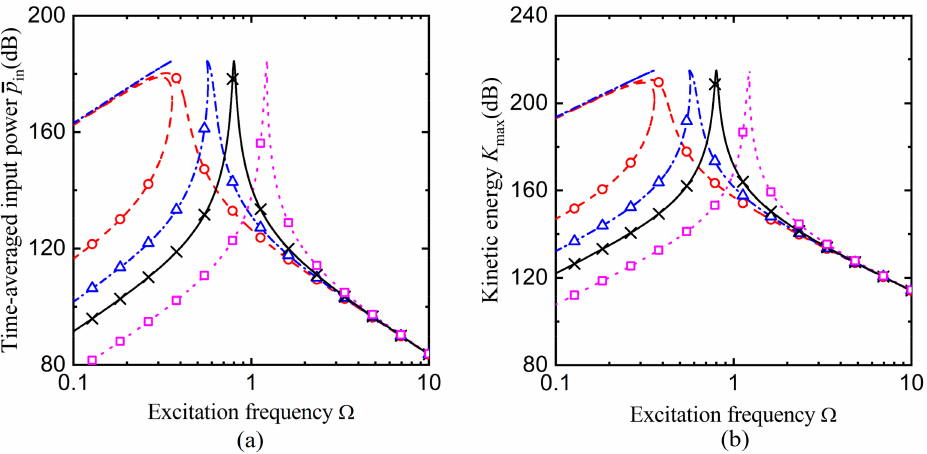
Figure 12. Effects of a varying product αβ on ( a ) the time-averaged input power and ( b ) the maximum kinetic energy ( ξ = 0.015, F 0 = 0.01 ) . Dashed, solid line, dash–dot, and dotted lines for ( α , β ) = ( − 1.2, 0.7 ) , ( − 1.6, 0.4 ) , ( − 1, 0.36 ) , and ( 0.2, 2.2 ) , respectively. Circles, triangles, crosses, and squares denote the corresponding numerical